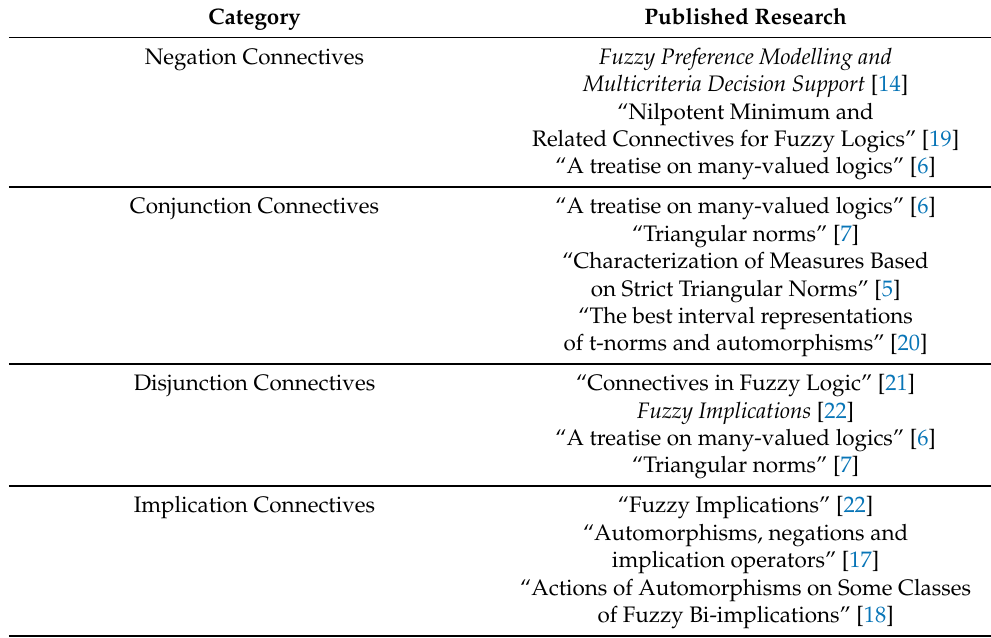
Table 1. Published research of every fuzzy connectives